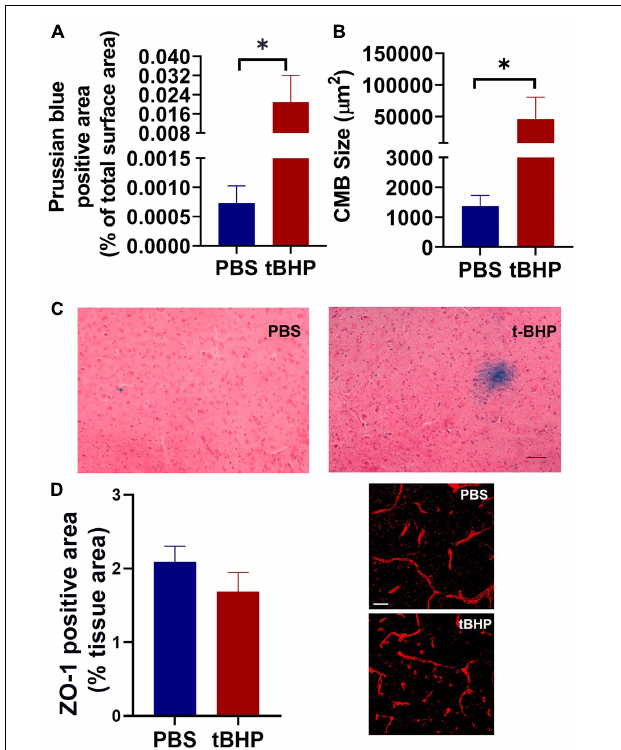
FIGURE 7 | In vivo iron-rich Prussian blue-positive cerebral microhemorrhage (CMH)-like lesion development. Aged mice injected with tBHP-RBCs had a higher total Prussian blue-positive lesion area (A) and individual lesion size (B) compared with the mice injected with PBS-RBCs. Representative Prussian-blue-positive lesions in mice injected with PBS- or tBHP-RBCs (C) . No significant difference in the ZO-1-positive area between the mice injected with tBHP-RBCs and PBS-RBCs was observed (D) . Data are presented as mean ± SEM of n = 3 per group. Scale bar = 200 µ m in panel (C) and 25 µ m in panel (D) . ∗ p = 0.05 with a Mann–Whitney U